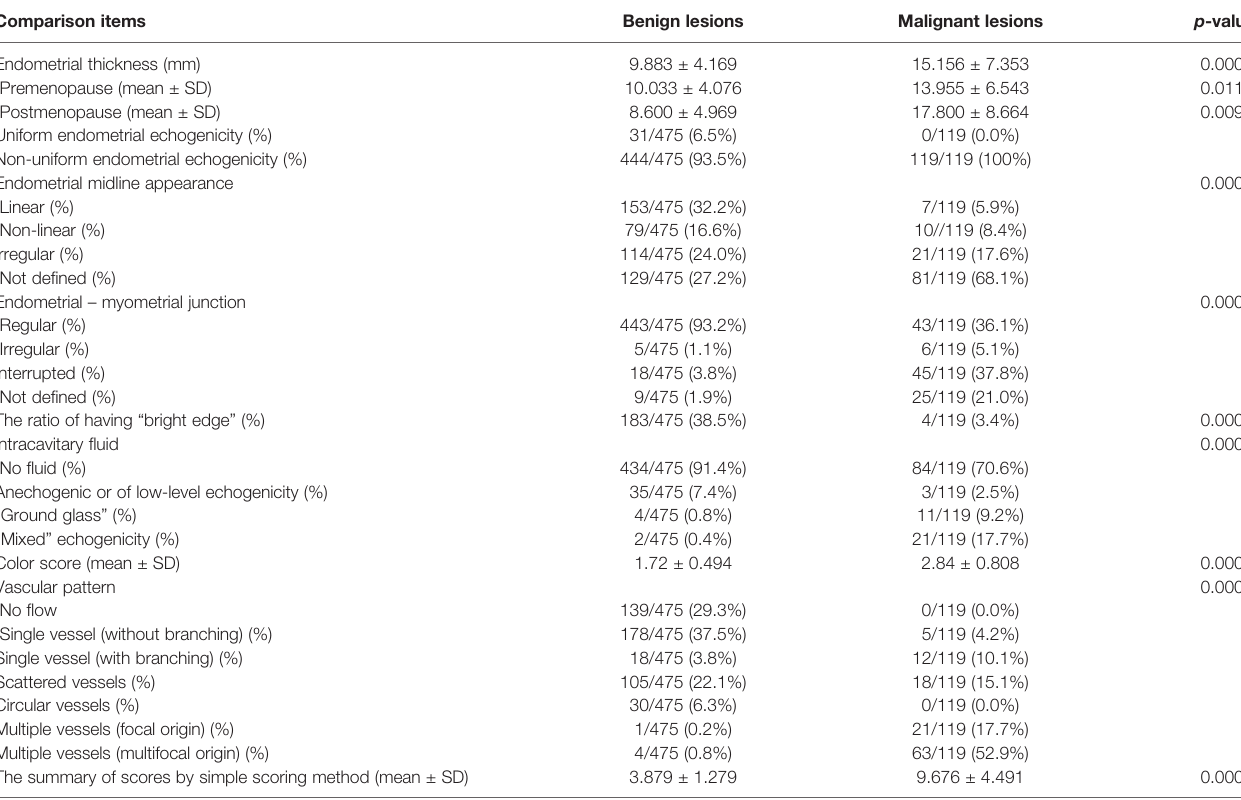
TABLE 4 | The IETA ultrasonographic characteristic comparison of benign and malignant lesions in uterine cavity or endometrium.